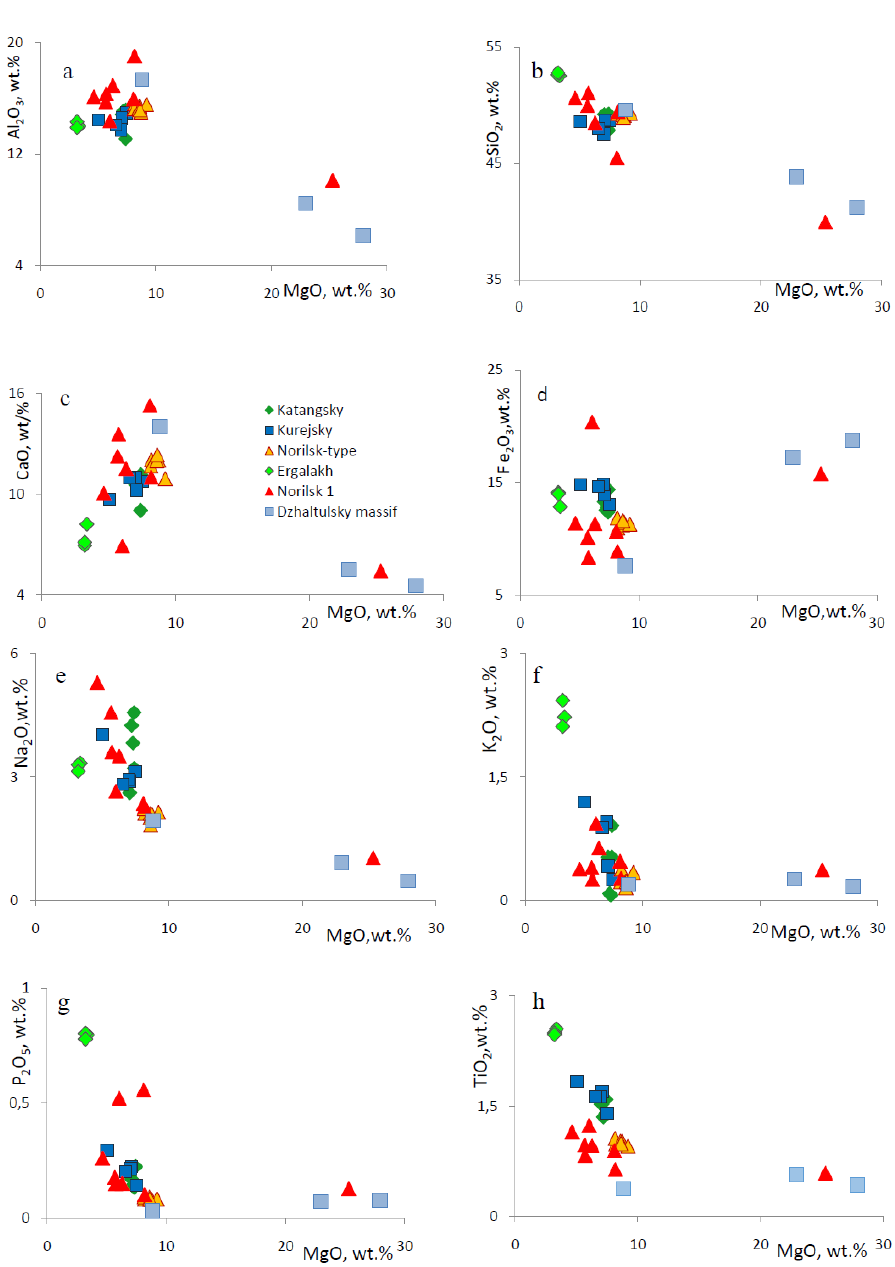
Figure 14. MgO (wt.%) vs. Al 2 O 3 ( a ), SiO 2 ( b ), CaO ( c ), Fe 2 O 3 ( d ), Na 2 O ( e ), K 2 O ( f ), P 2 O 5 ( g ), TiO 2 ( h ) for intrusive rocks.